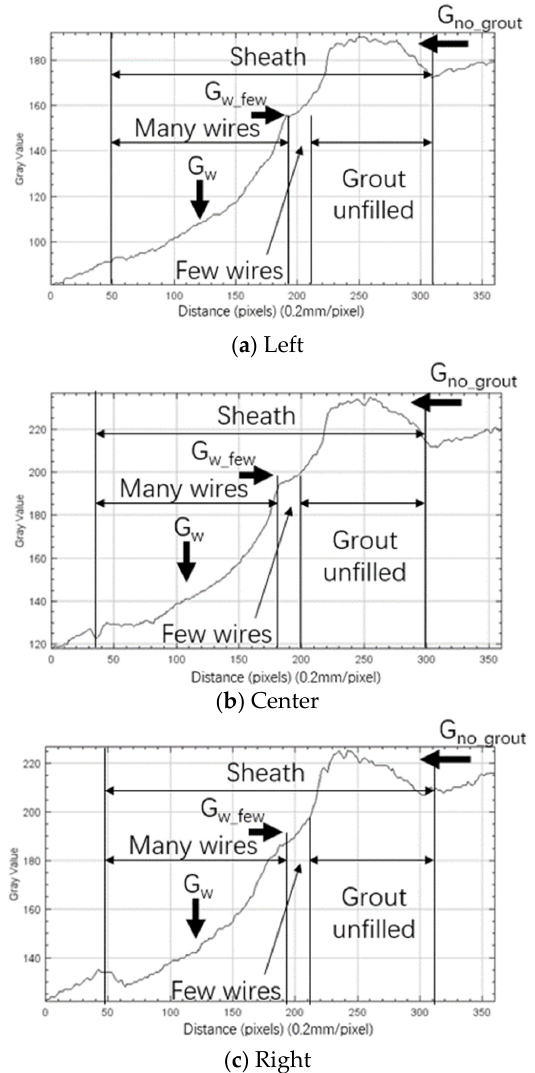
dark and less dark, that is, G w_few > G w .